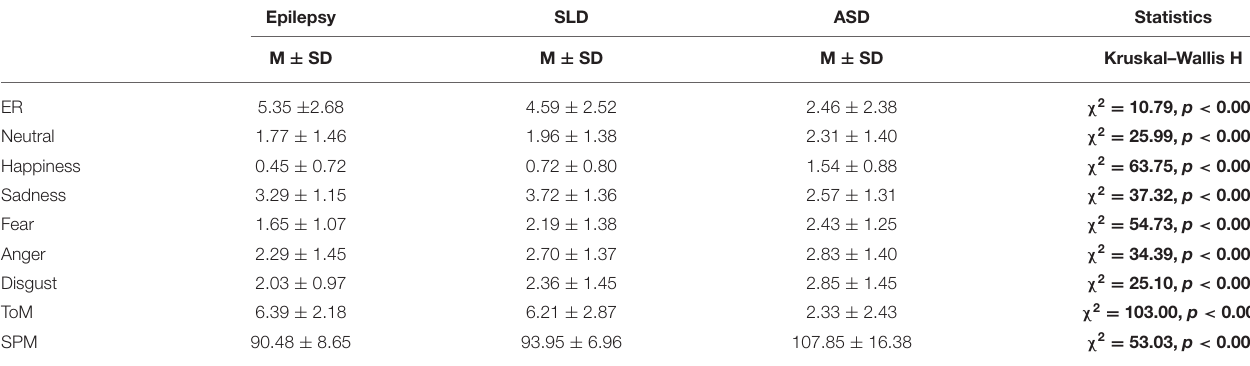
TABLE 3 | Comparison among groups with nonparametric analysis of variance